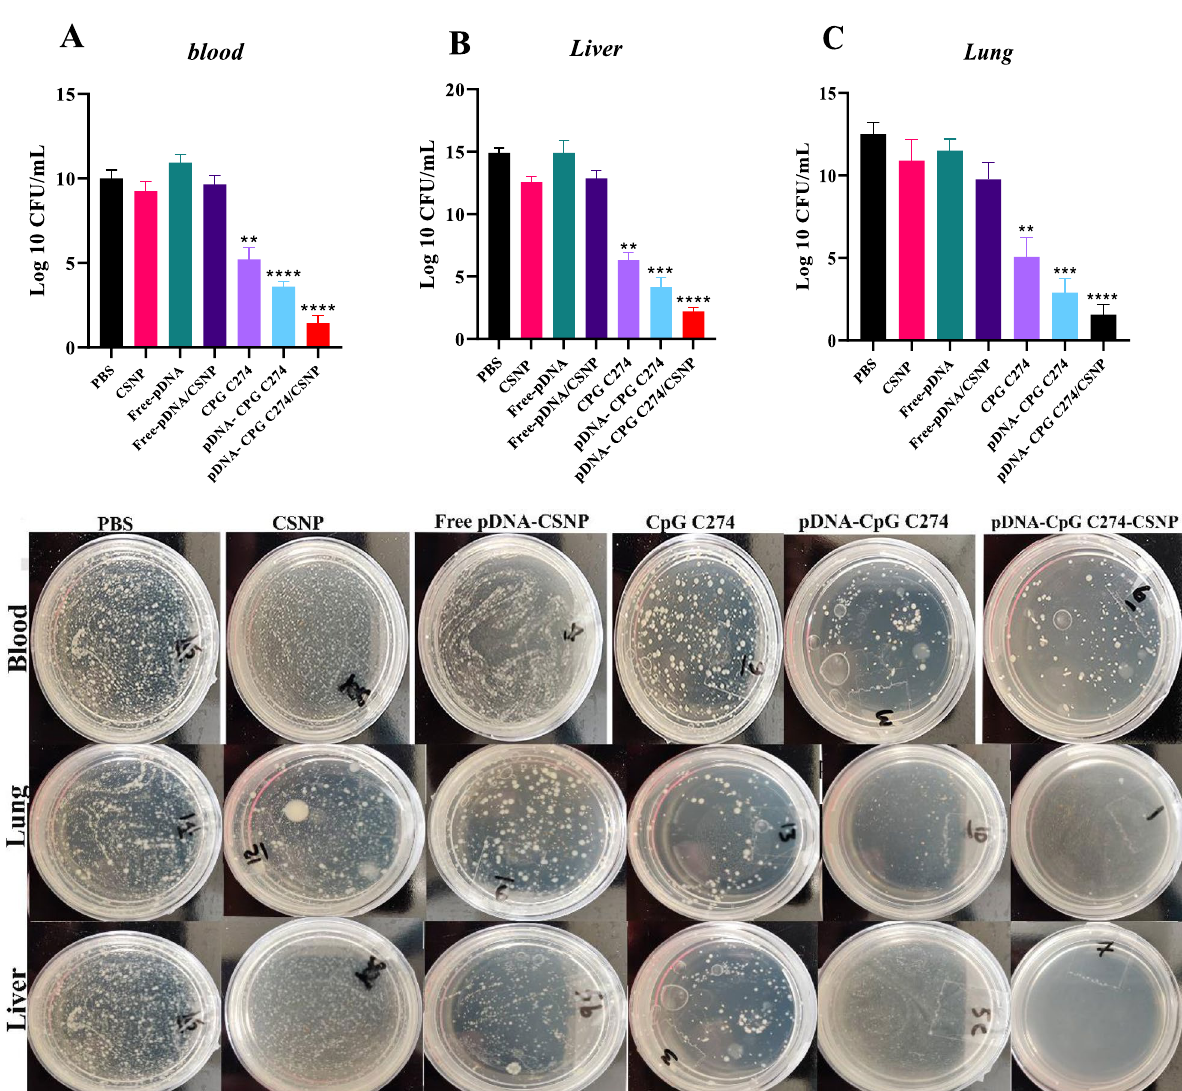
Fig. 6 Bacterial burdens in BALB/c mice’s blood, liver, and lung tissues. The procedure of vaccination and A. baumannii challenge. BALB/c mice were infected with fatal concentrations of A. baumannii ATCC19606 (2108 CFU/mouse) 3 weeks after their last vaccination. A Bacterial burdens in mice’s blood 24 h after the challenge. Bacterial burdens in the liver and lungs B–C . After a 24‑h challenge with A. baumannii , the liver and lungs were removed. The mean SD (n 6) is indicated by the bars. ( ns nonsignificant, *p =